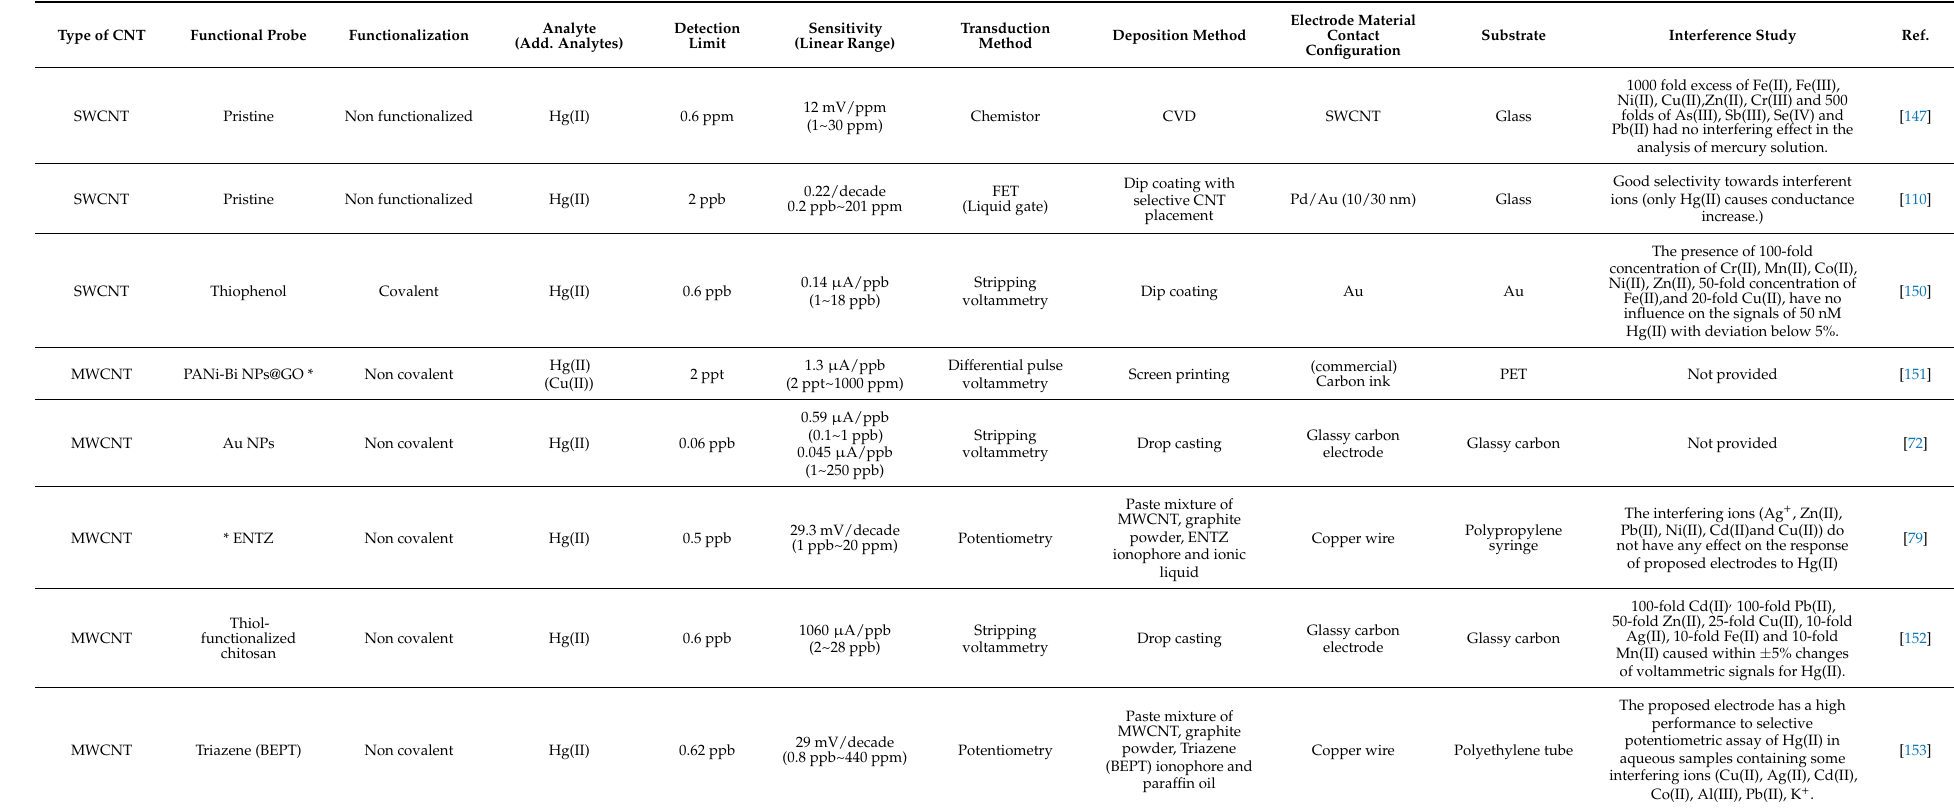
Table 6. CNT-based sensors for detecting Hg(II) ions in water, sorted by type of functionalization, then detection